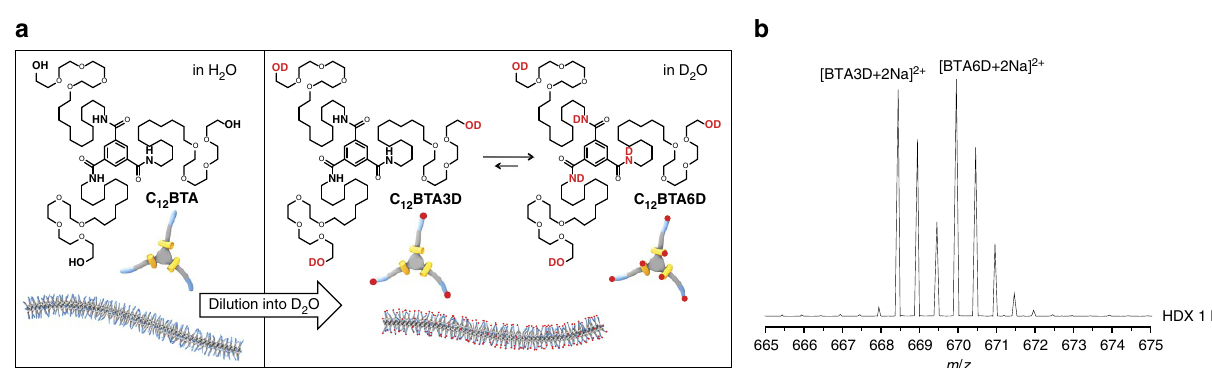
Figure 1 | The H - D exchange reaction. ( a ) Chemical structures of C 12 BTA and its deuterated analogues C 12 BTA3D and C 12 BTA6D, schematic representation of the supramolecular polymers formed in water and an illustration of the H/D exchange process. ( b ) ESI-MS spectrum of C 12 BTA diluted into D 2 O after 1h